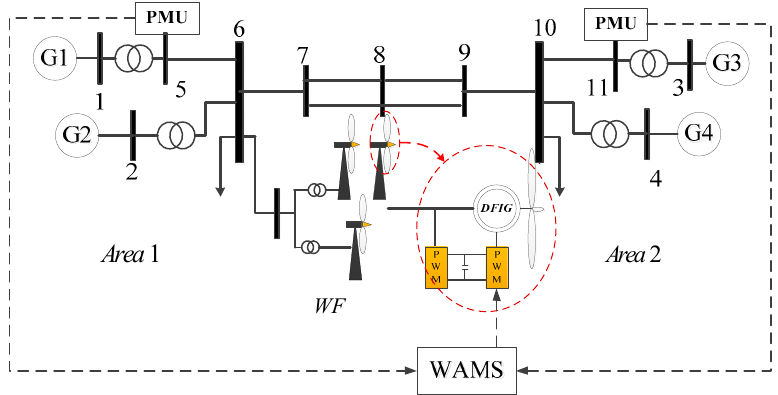
Figure 5. The simulation diagram of 2-area 4-machine system with DFIG wind farm.